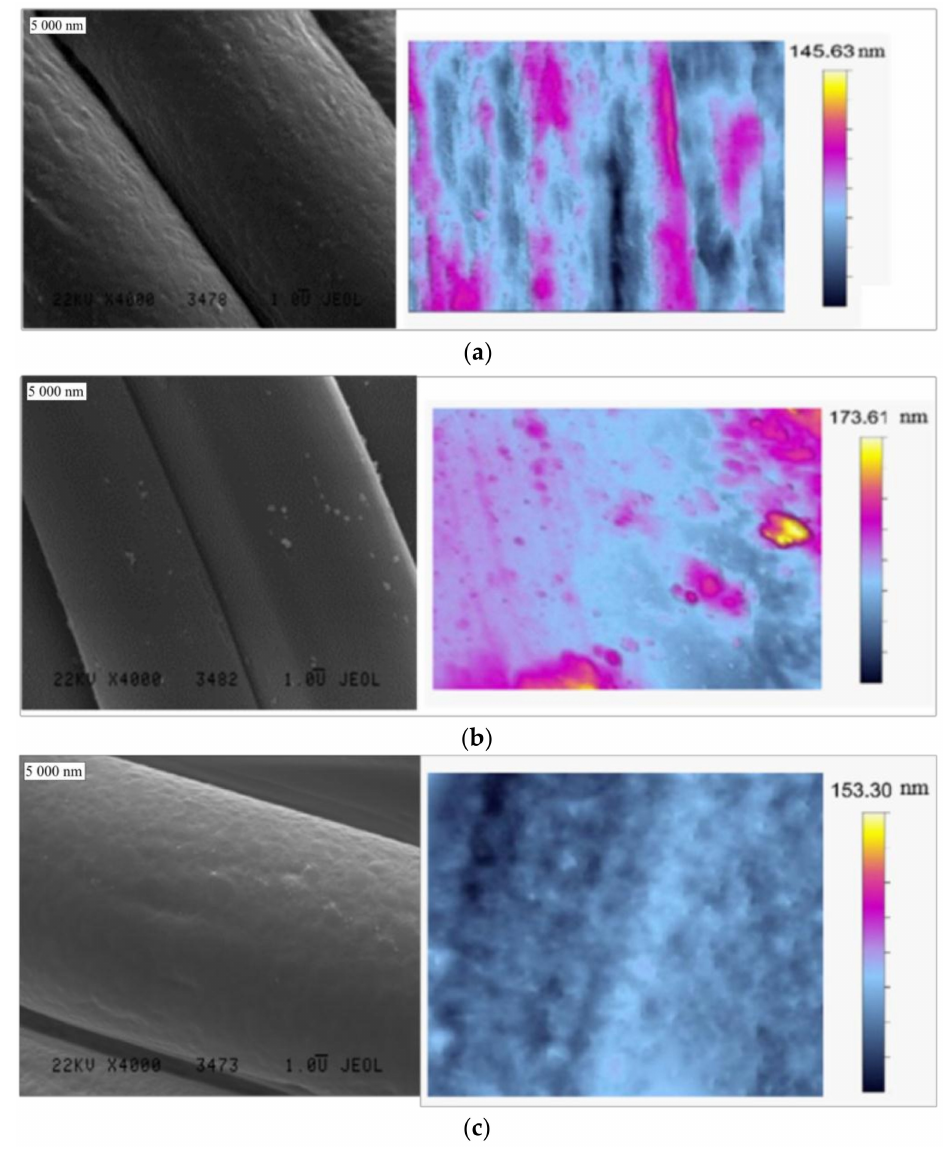
Figure 1. SEM and AFM images of: ( a ) PA; ( b ) PET; and ( c )